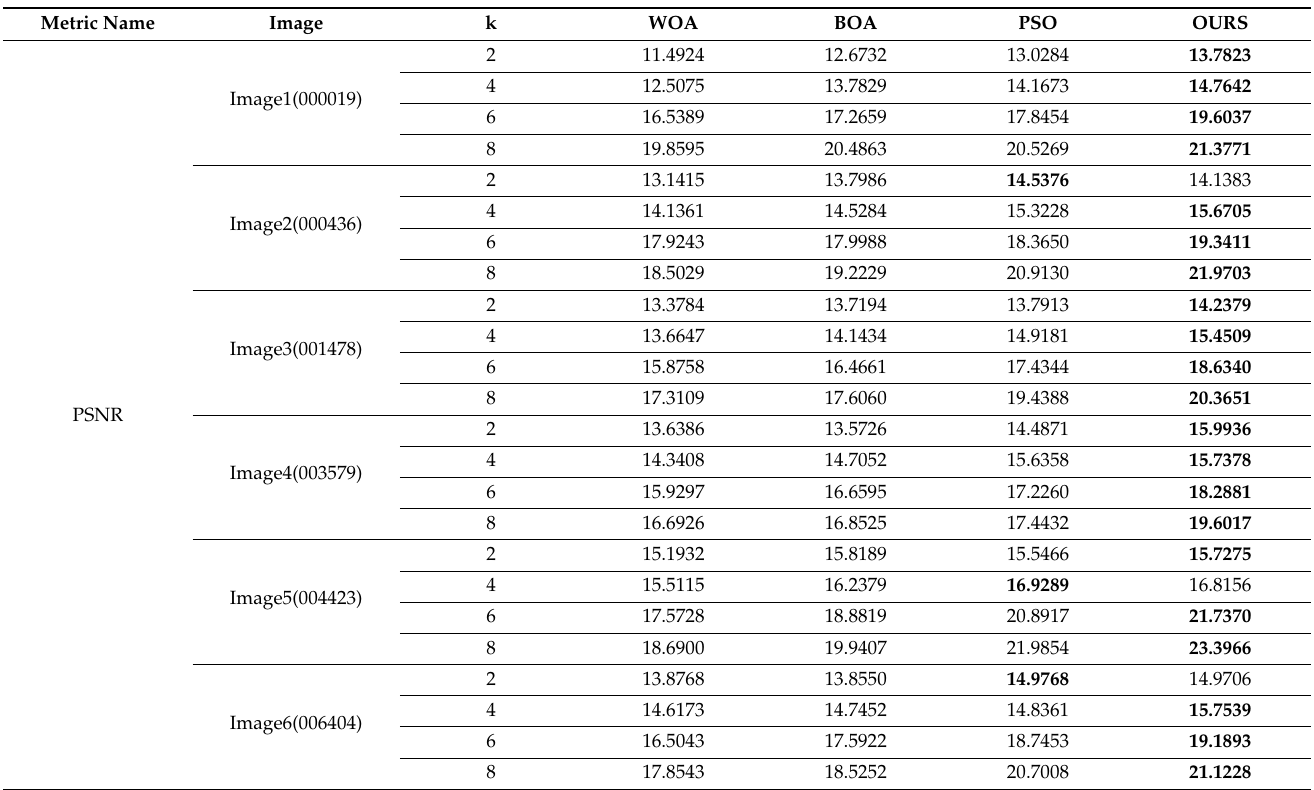
Table 3. Comparison of PSNR in images a–f.